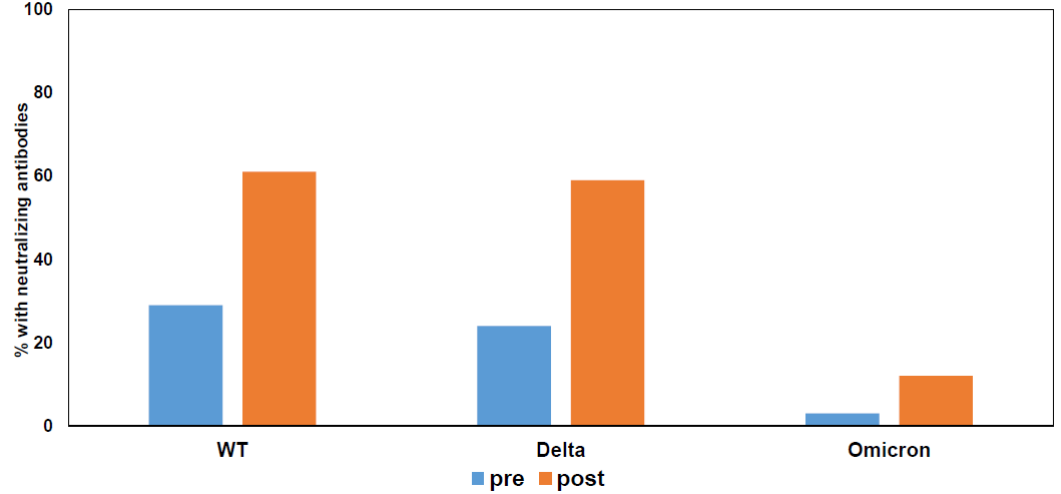
Figure 4. Proportion of KTx recipients with a positive neutralization response before and after the third vaccine dose.